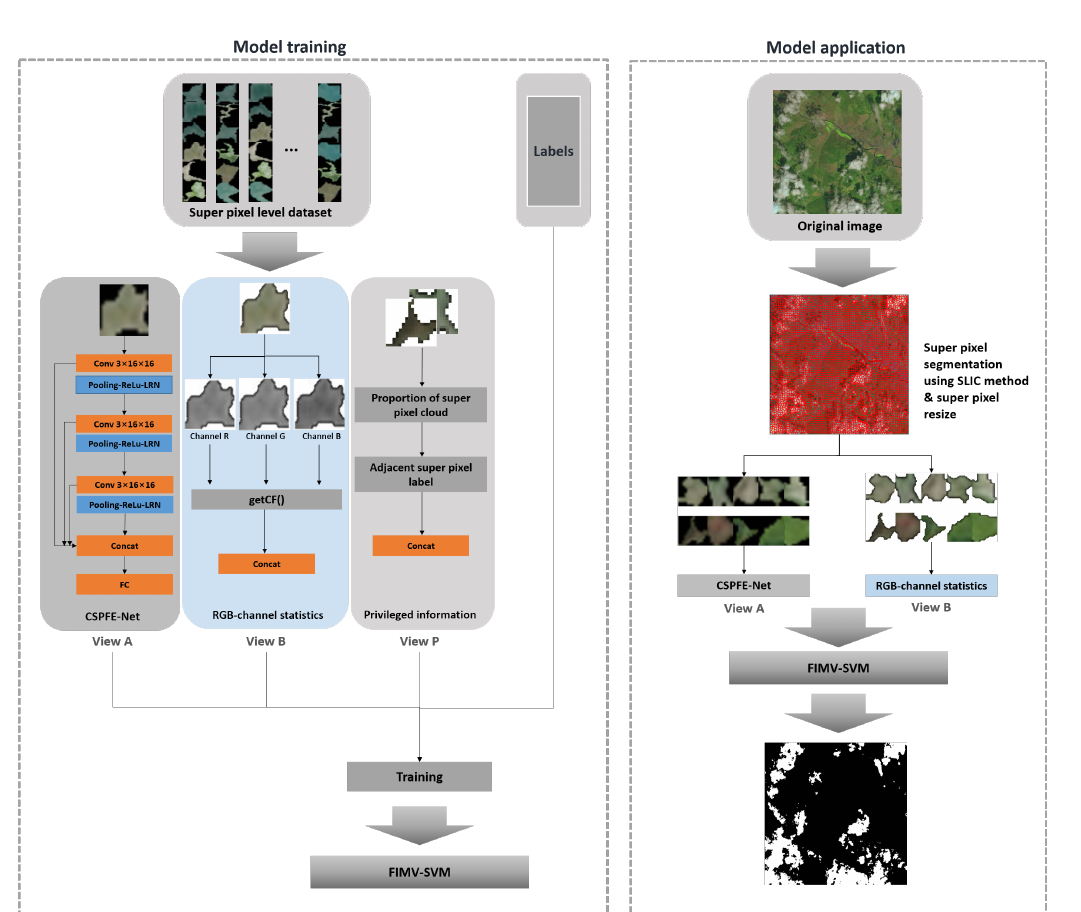
Figure 2. FIMV-SVM cloud detection model training and application process